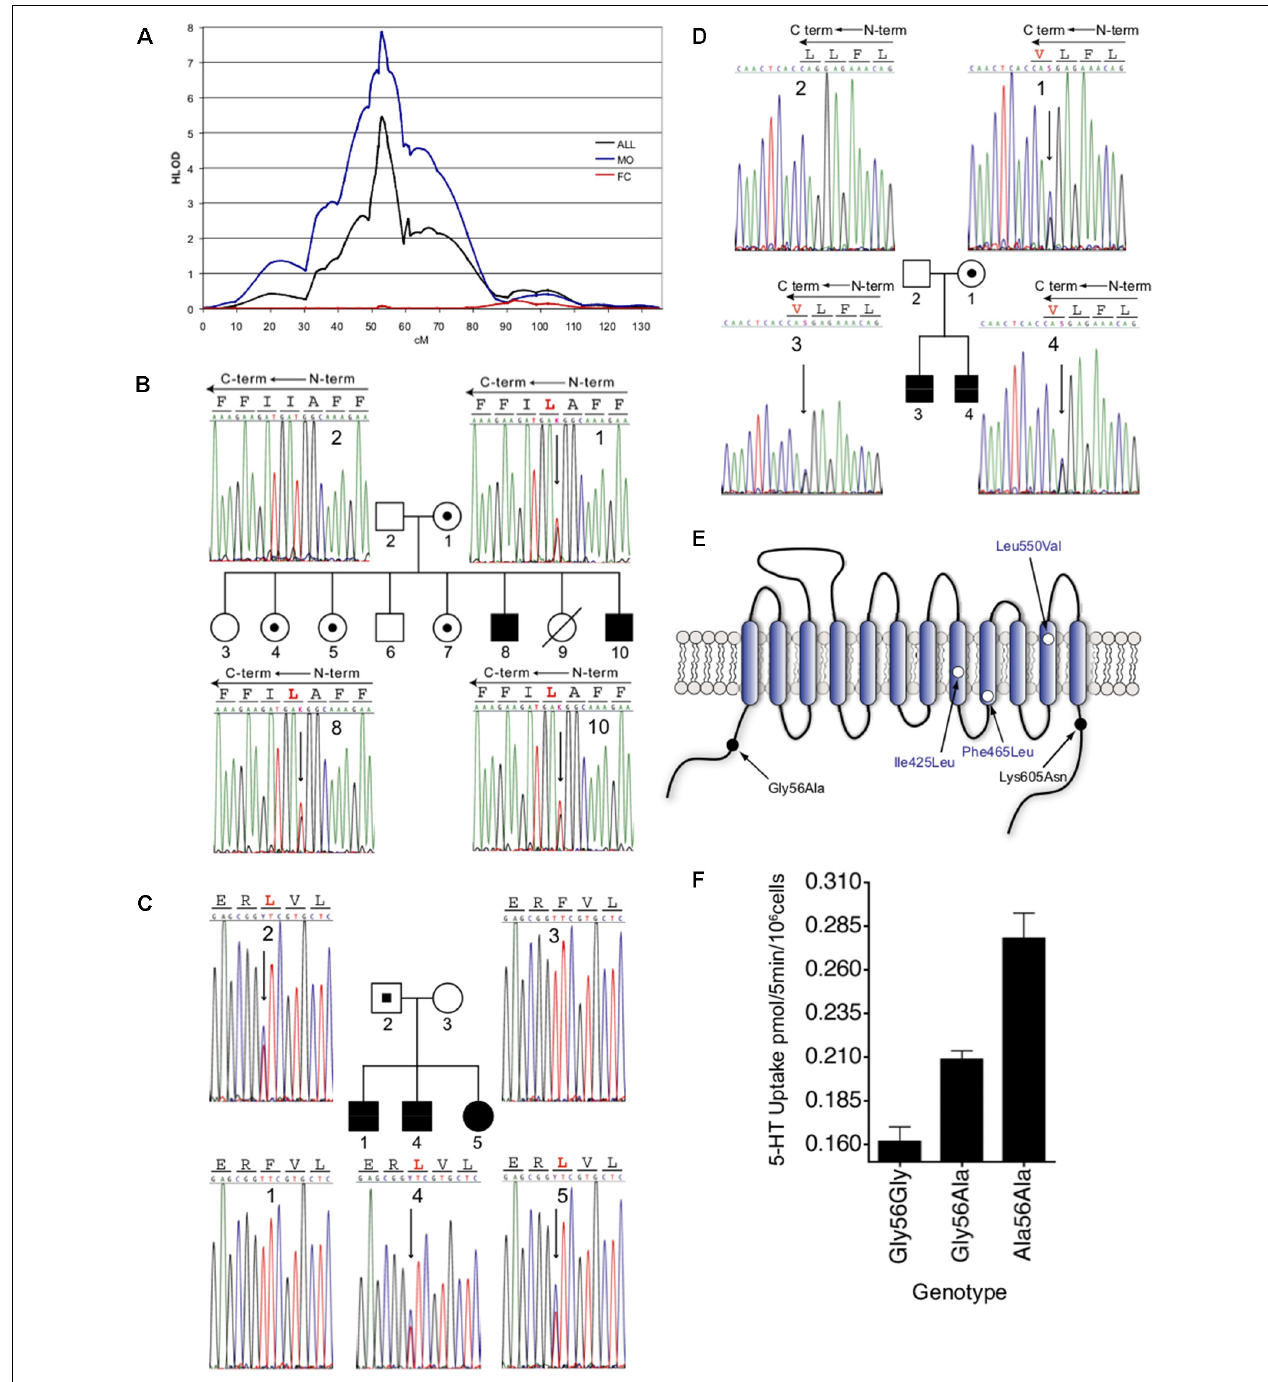
FIGURE 1 | Male-biased linkage of autism and novel coding variants at the 17q11.2 SLC6A4 locus. (A) . Male-biased linkage of autism to 17q11.2. Multipoint linkage analysis on chromosome 17 is shown for the overall 341-family data set ( black line ), 202 MO families ( blue line ), or the remaining 138 FC families ( red line ). HLOD scores were calculated under a recessive model and were plotted as a function of marker position in centimorgans (cM) along chromosome 17. (B–D) Sequence detection of novel nonsynonymous SLC6A4 variants in families with autism. Sequence-based detection is shown for each of the three novel coding variants, with corresponding pedigrees. (B) Ile425Leu. (C) Phe465Leu. (D) Leu550Val. Blackened circles or squares reflect individuals with an autism diagnosis, unblackened circles or squares reflect individuals without autism, and allele carriers without autism are indicated by small blackened circles or squares within the larger pedigree symbol. Electropherogram data is shown in either sense (B) or antisense (A,C) orientations, with corresponding coding sequence. Antisense